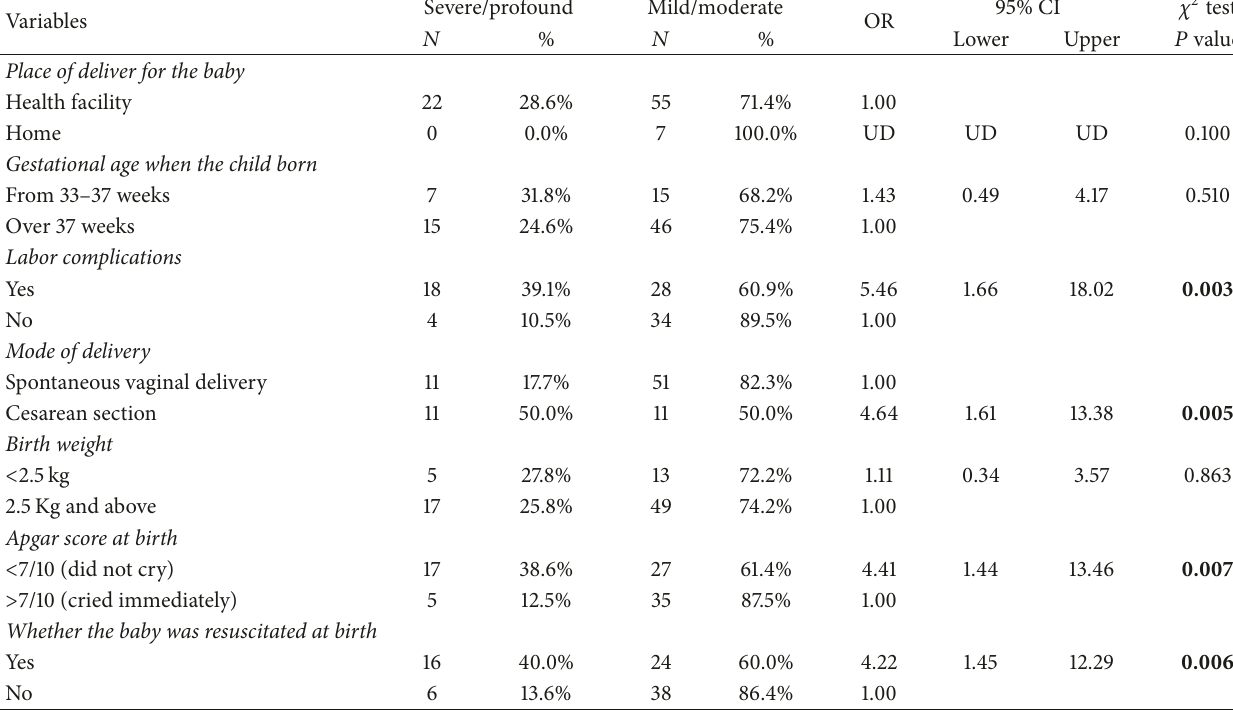
Table 6: Association between birth history of the children and severity of intellectual disability.